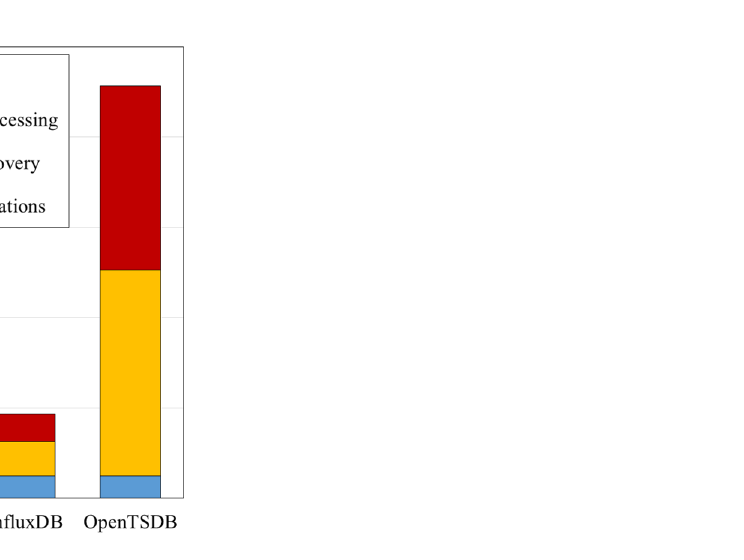
Figure 20. Performance of different TSDBMSs in the machine operational status tracking